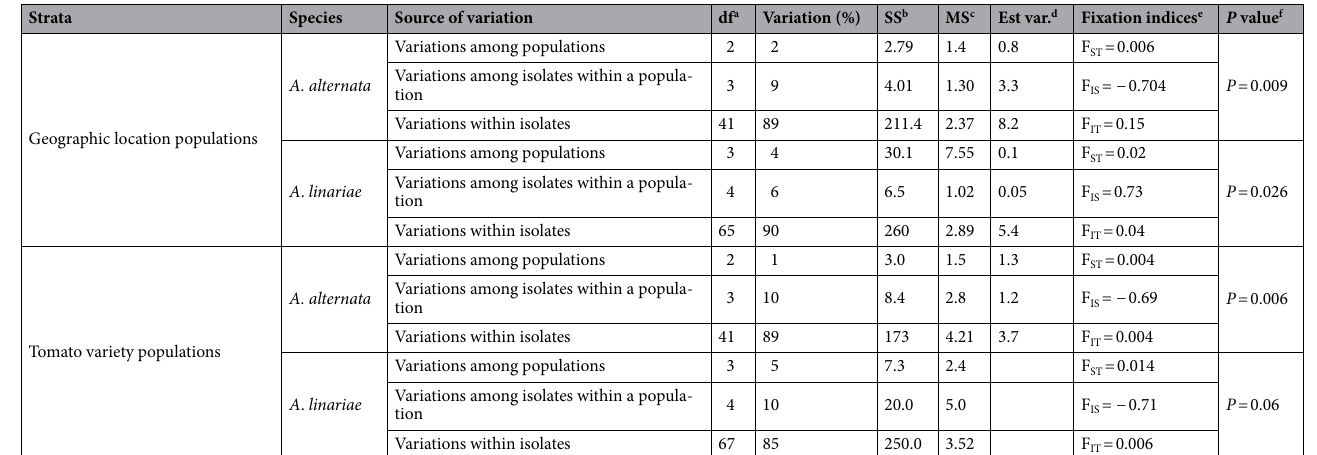
Table 3. Analysis of molecular variance (AMOVA) of the clone-corrected datasets of Alternaria alternata and A. linariae populations collected from different geographic locations and tomato varieties in North Carolina using 220 single nucleotide polymorphisms (SNPs) from 10 microsatellite loci. a df = Degrees of freedom and populations of Alternaria species were defined in the methods. b SS = Sum of squared observations. c MS = Mean squares. d Est. var. = Variance components. e Fst = Variations among locations or tomato varieties; Wright’s inbreeding coefficient (F IS ) = variations among isolates within locations or tomato varieties, and F IT = variations within isolates. f P = Probability value was estimated based on 1000 permutations.